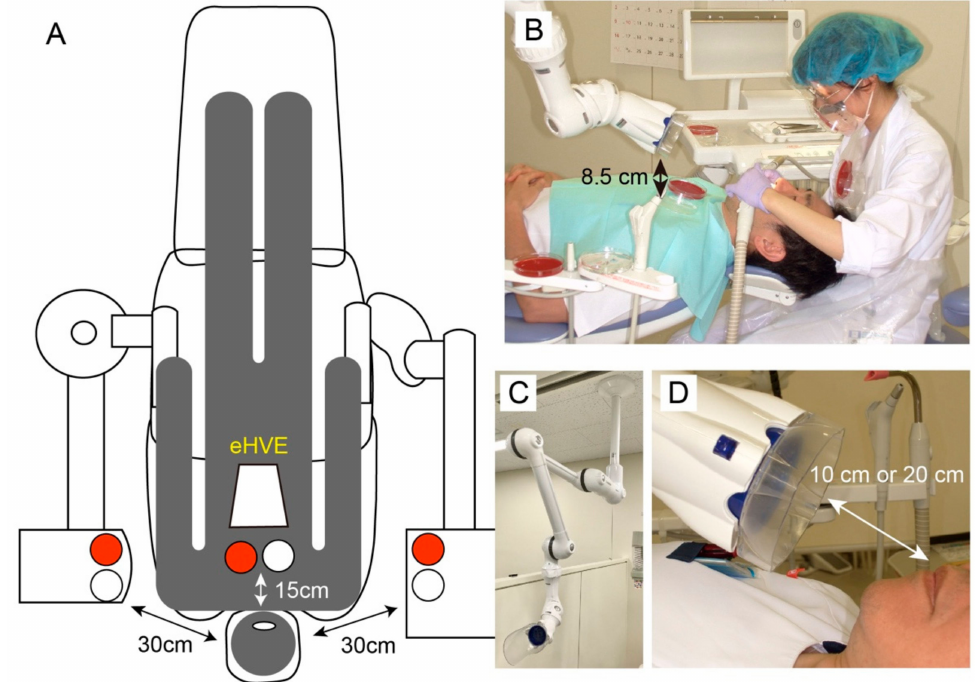
Figure 2. Positional relationship between sampling site and extraoral high volume evacuator (eHVE). ( A ) Dental unit and clinical test locations. Red and white circles indicate a blood agar plate and a Petri dish, respectively. ( B ) Positional relationship seen from side. ( C ) eHVE. ( D ) Positional relationship between eHVE and mouth. Distances of 10 and 20 cm were